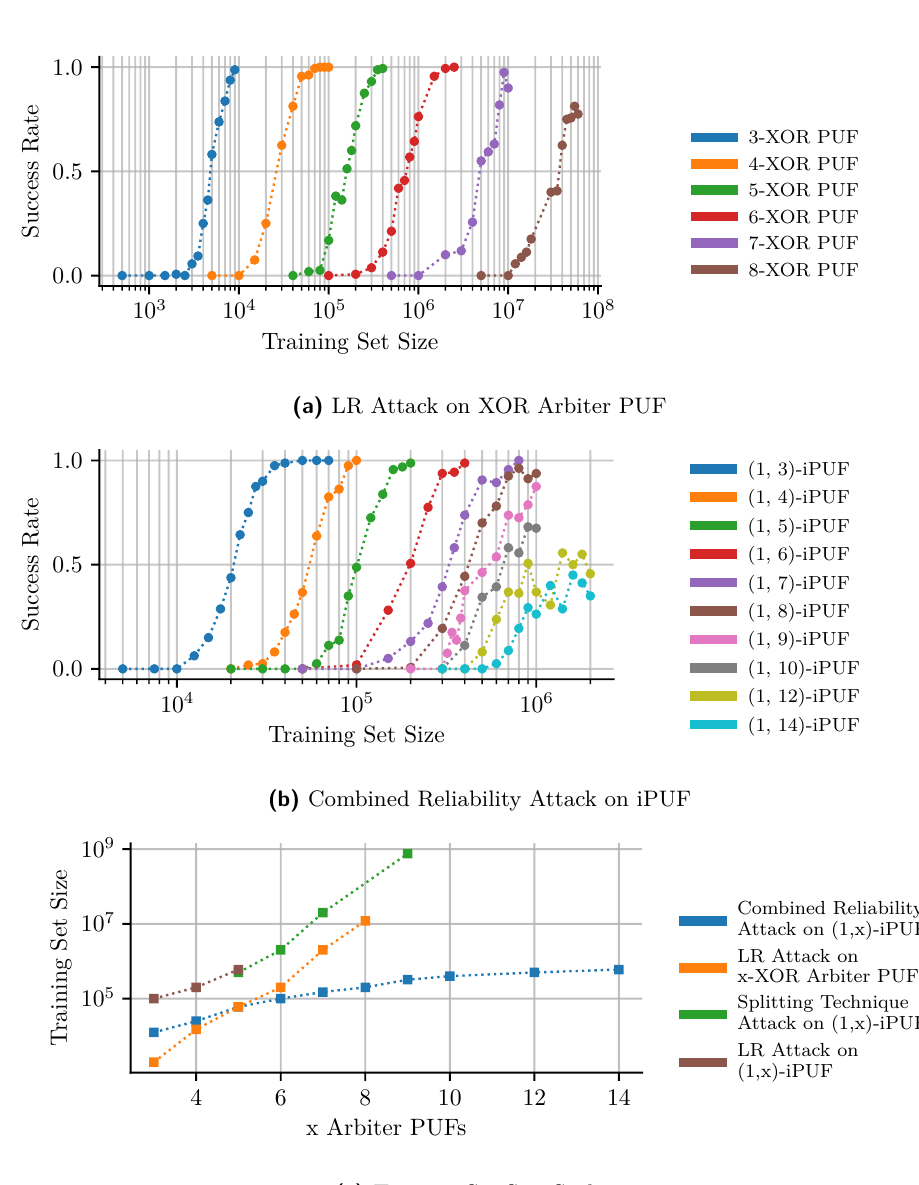
Figure 7: For the learning curves in (a) and (b), we have attacked at least 20 PUF instances with 8 tries per instance for each point. The constraint constants for the reliability attack are given in Table 6. For the experiments in (b), we have fixed the noise σ 2 per single noise APUF to 0 . 1 and the number or reliability queries per challenge to 10 for all instances. All other experiments were run noise-free. In (c), we compare the training size complexity for different attacks. The curves for the LR attack on XOR-Arbiter PUFs and the reliability attack on iPUFs are taken from the data presented in (a) and (b) and show the lowest training set size for which the success rate was above 0. The LR attack on the iPUF is given for a higher success rate (see Table 4). The values for the LR-based split attack are as given by Wisiol et al.[WMP + 20]. The success rate for these values was one, except for the (1,9)-iPUF where it is 0.26. Note that the training set size in all three figures denotes the number of unique challenges in the training set which does not include the additional PUF queries that are required for the reliability attack. The number of additional queries does not grow with the number of single